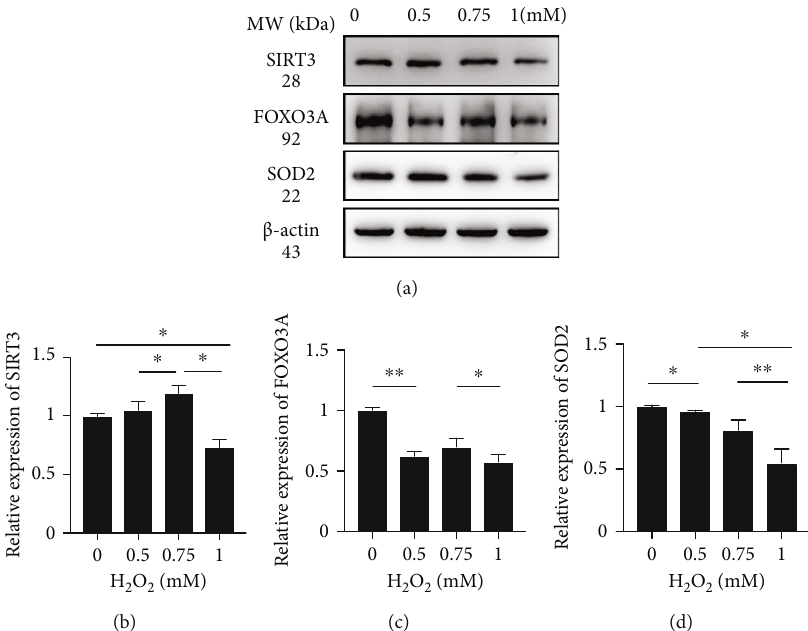
Figure 5: H O induces downregulation of SIRT3, FOXO3A, and SOD2. (a) Representative western blot analysis using antibodies against 2 2 SIRT3, FOXO3A, SOD2, and β -actin in CBMs. (b) Protein expression of SIRT3 in the 0, 0.5, 0.75, and 1mM groups. (c) Protein expression of FOXO3A in the 0, 0.5, 0.75, and 1 mM groups. (d) Protein expression of SOD2 in the 0, 0.5, 0.75, and 1mM groups. Data are expressed as means ± SD ( n = 5 organ of Corti per concentration). ∗ P < 0 : 05 , ∗∗ P < 0 : 01 , and ∗∗∗ P < 0 : 001